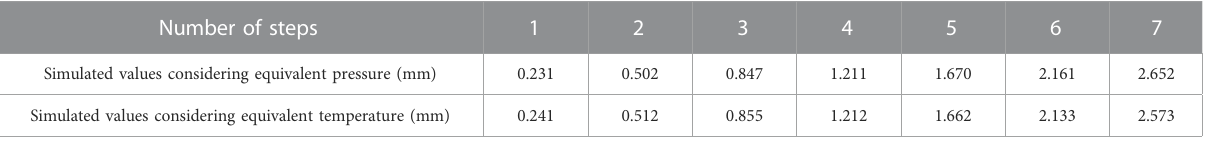
TABLE 7 HPC deformation calculated by simulation.